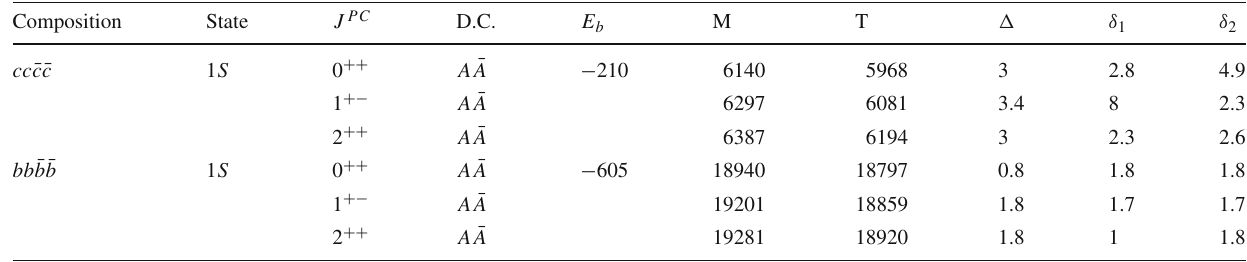
and δ 1 and δ 2 arethepercentagedifferencebetweenourresultsandRefs. [41,42] respectively. D.C., is the diquark content and E b is the binding energy. All values are given in